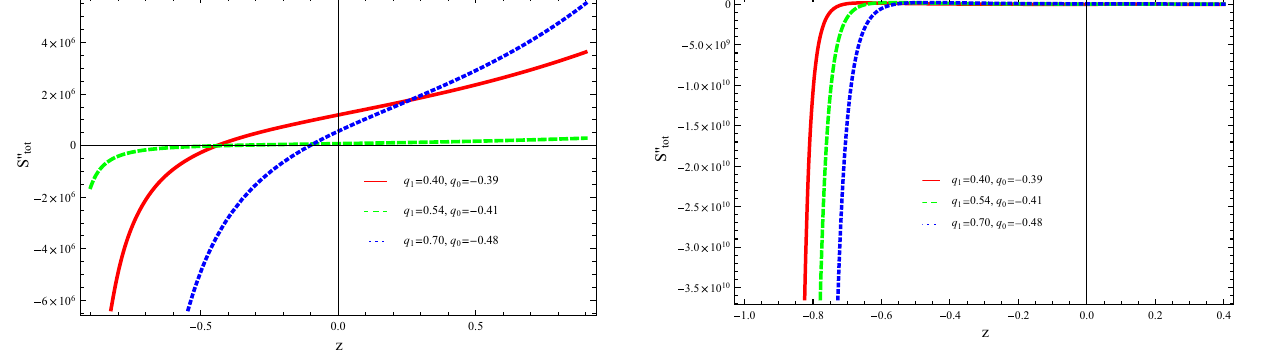
Fig. 8 Plot of S (cid:5)(cid:5) tot versus z at Hubble horizon with Bekenstein entropy